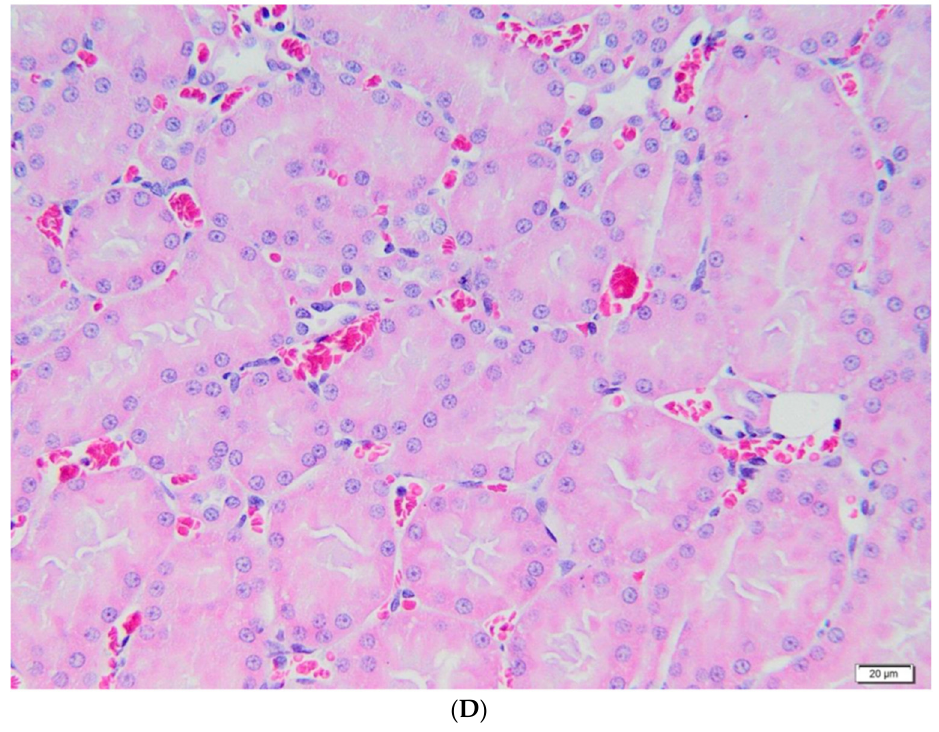
Figure 4. Control group — histological aspects. ( A–C ) — Renal cortex, including the unmodified morphological aspects of the tubules, glomeruli and the interstitium; ( D ) — Renal tubules made up of cuboidal cells, with a brush border, showing intracytoplasmic fine granulations, acidophilic, located toward the basal pole of the cells, specific to the rat and without pathological significance.